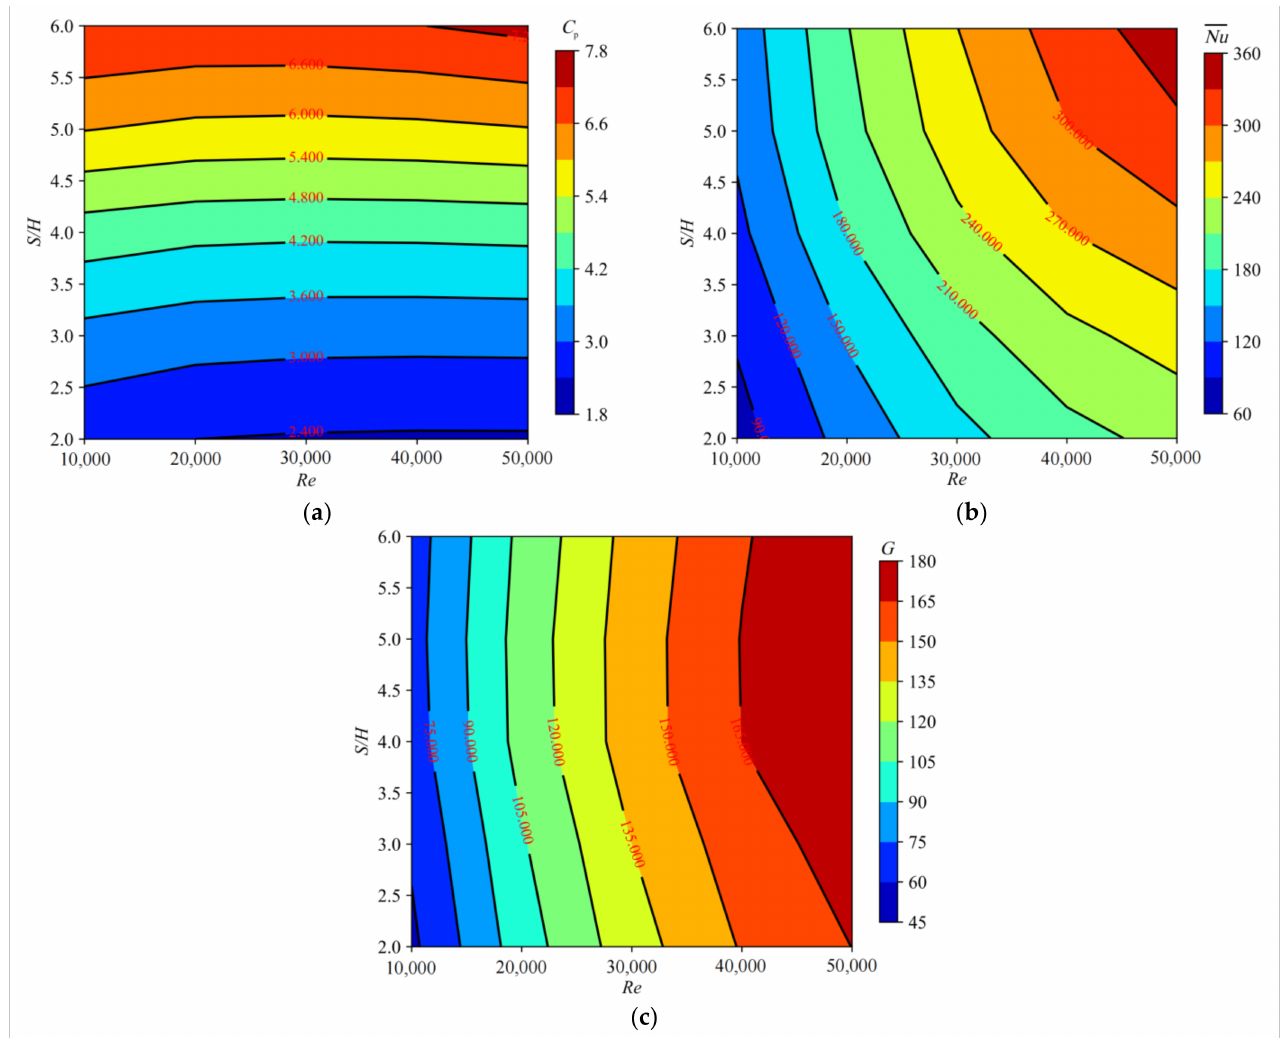
Figure 12. Effects of S/H on the pressure loss coefficient, average Nusselt number, and comprehensive thermal coefficient of the quasi-leading-edge channel under steam cooling: ( a ) pressure loss coefficient; ( b ) average Nusselt number; ( c ) comprehensive thermal